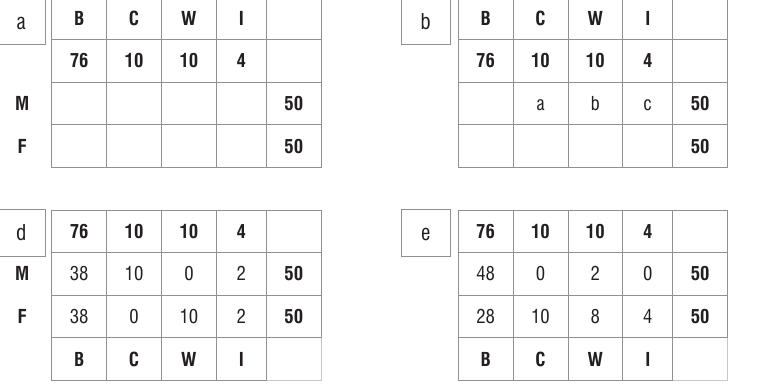
Table 1: (a) to (f) Structures of pseudo-university population percentages for distinct scenarios B C